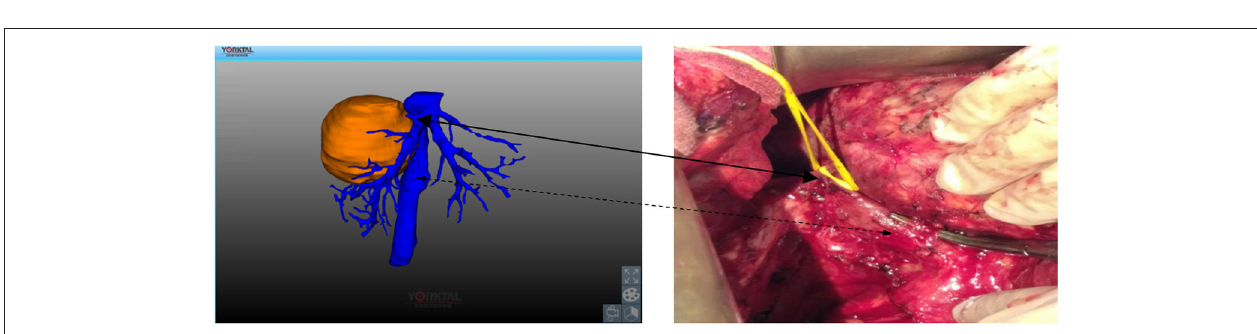
FIGURE 3 | Invasion of the right hepatic vein and inferior vena cava by hydatid. Solid line arrow: right hepatic vein; Dashed arrow: inferior vena